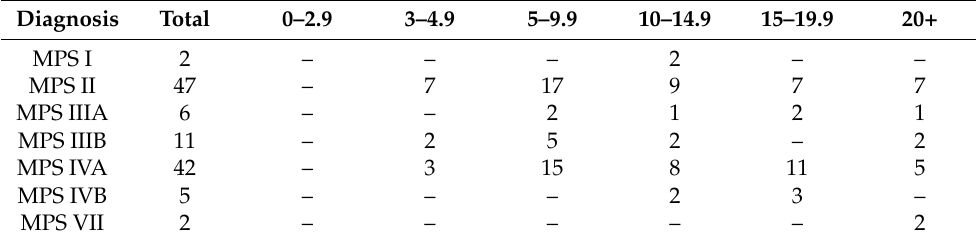
Table 1. Types of mucopolysaccharidosis (MPS) and ages of patients with MPS. Diagnosis